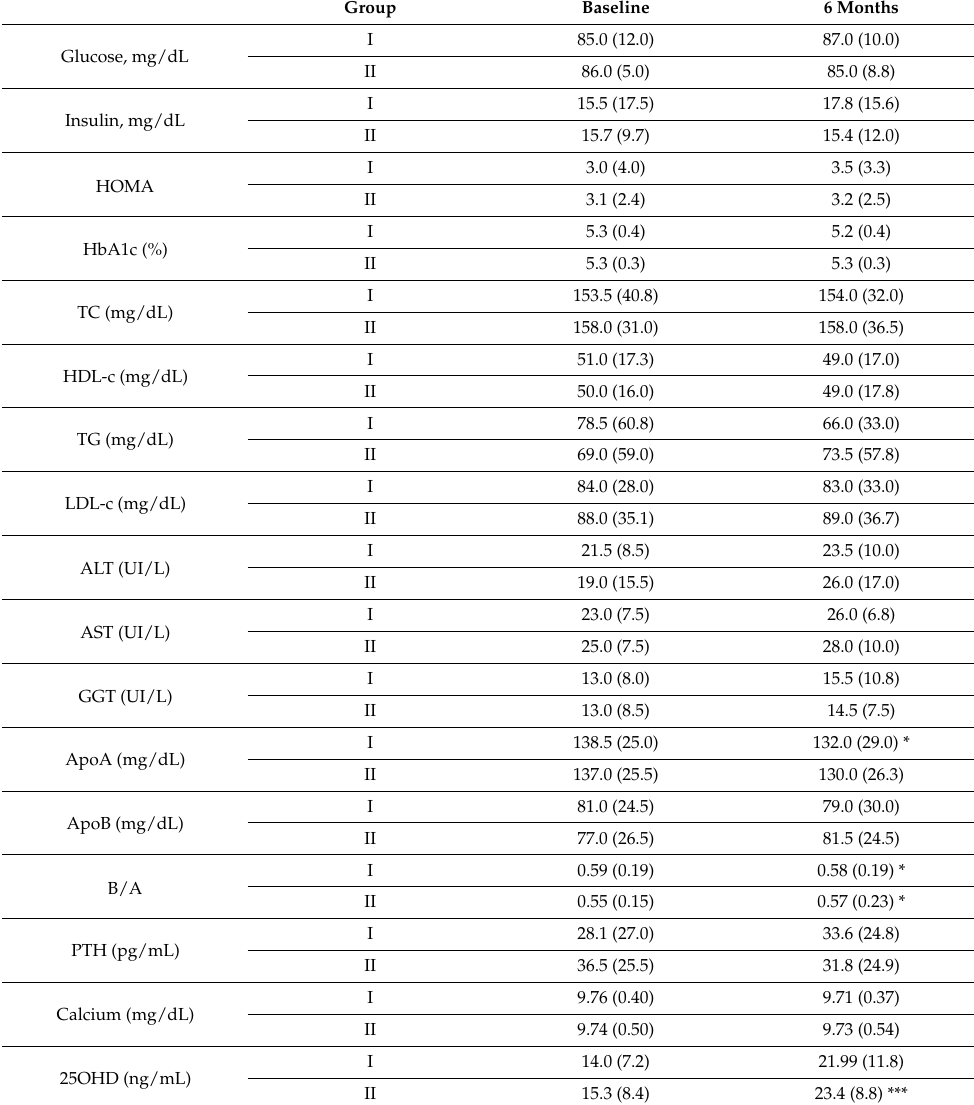
Table 3. Laboratory/biochemical variables in D + DHA group and vitamin D group at baseline and after 6 months. Data are expressed as median (IQR).